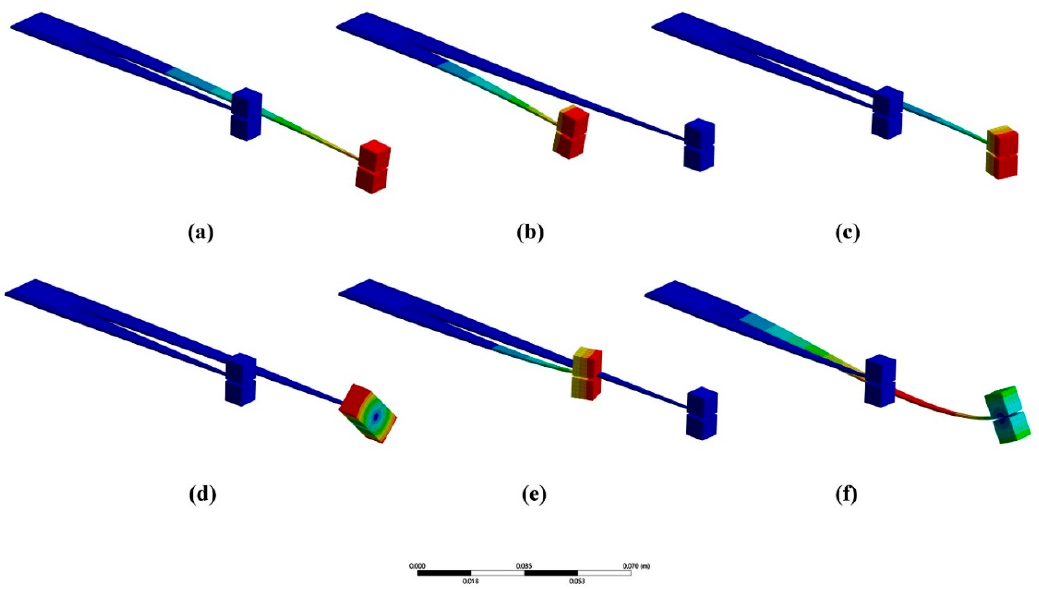
Figure 3. Deformation shapes of first six resonances of MRPEH obtained from ANSYS modal analysis. ( a ) NF1; ( b ) NF2; ( c ) NF3; ( d ) NF4; ( e ) NF5; ( f ) NF6 (NF: Natural Frequency).